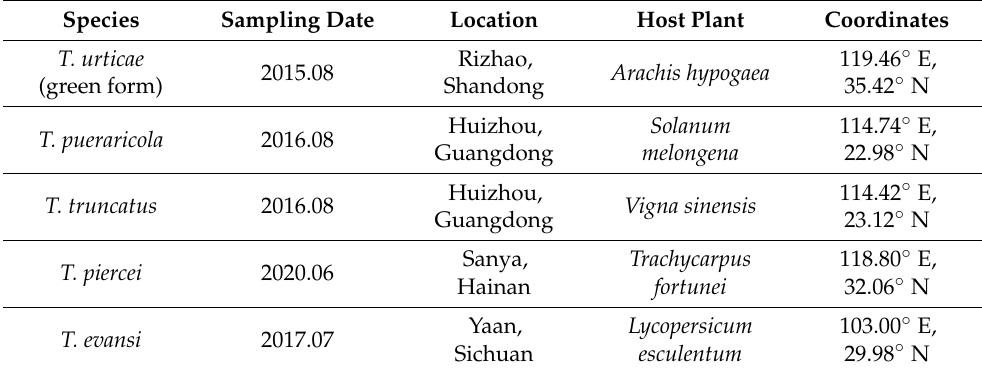
Table 1. Sampling information of spider mites used in this study.